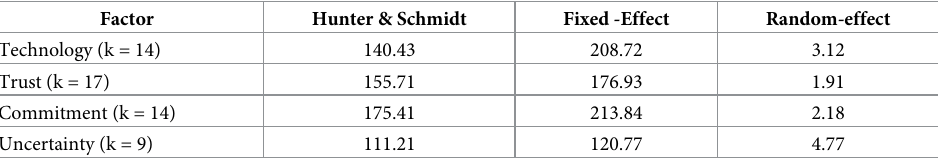
Table 6. Homogeneity test